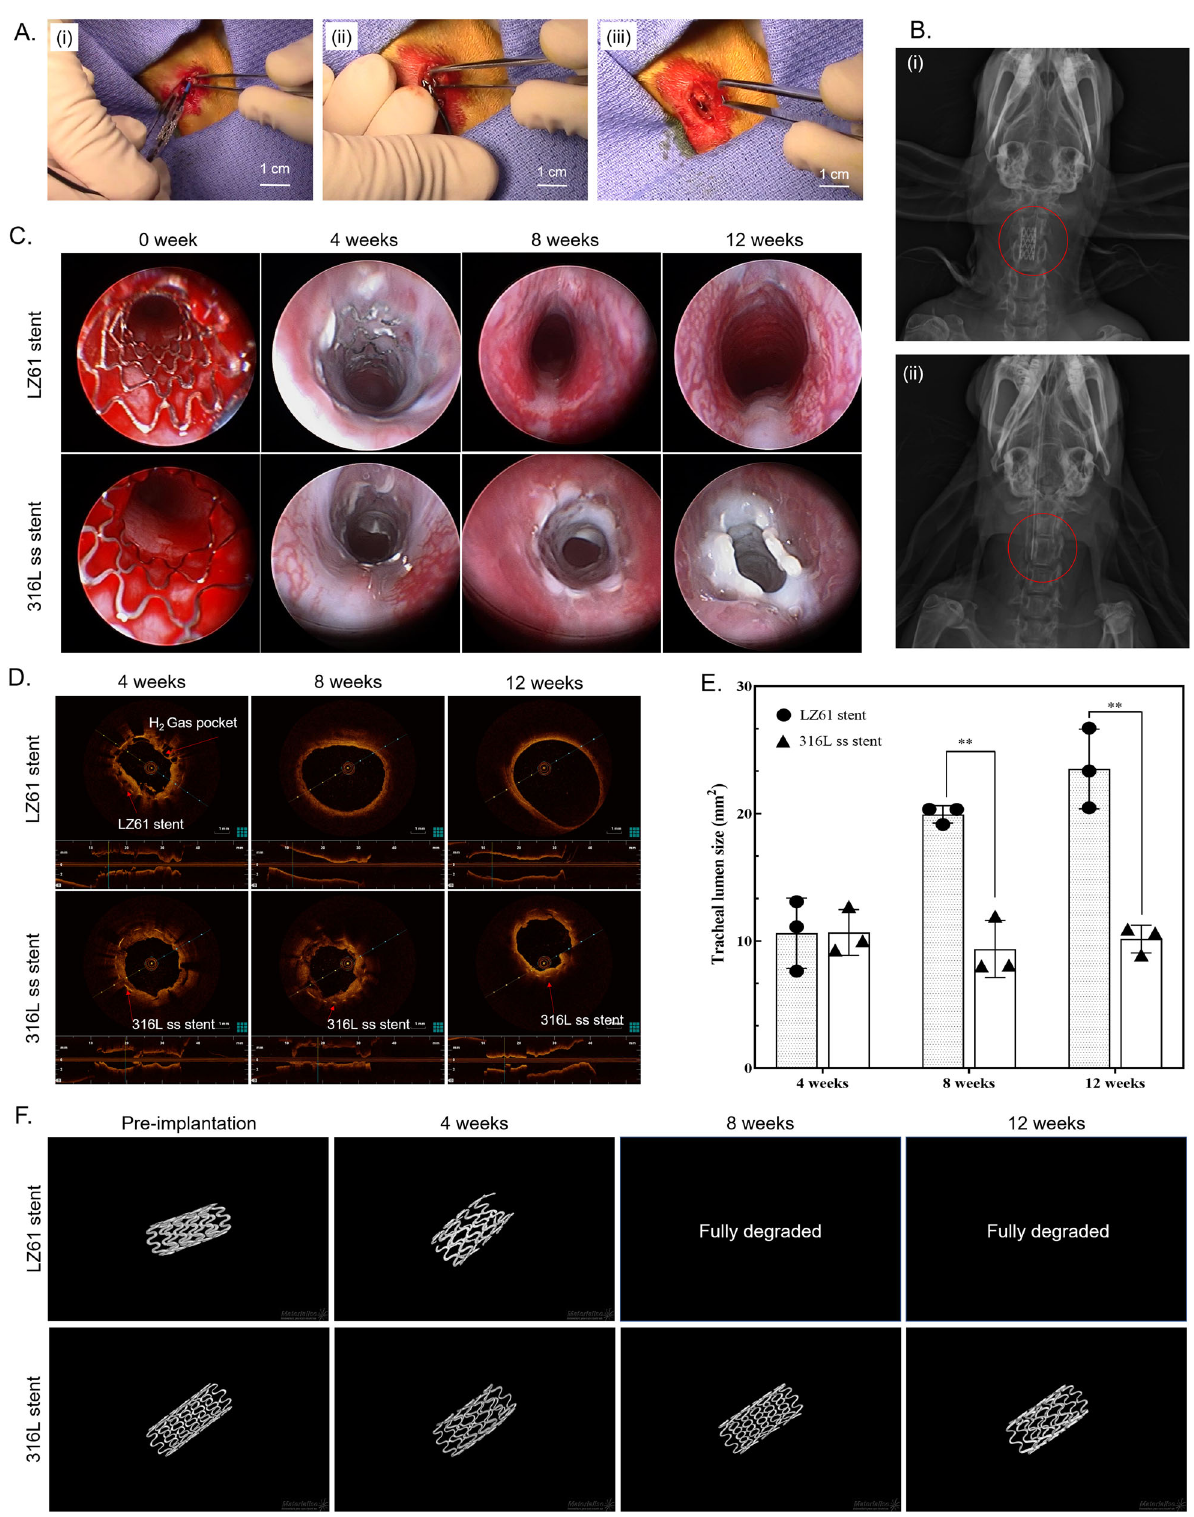
Fig. 3 In vivo implantation of LZ61-KBMS stents in a healthy rabbit tracheal model. A The surgical procedure of the stent placement. (i) Tracheal stent was mounted on the balloon. (ii) The balloon was injected with saline and expanded the tracheal stent against the tracheal wall. (iii) The balloon was de fl ated and pulled out of the trachea leaving the stent inside the tracheal lumen . B X-ray image of the implantation site of the (i) 316L SS stent and (ii) LZ61-KBMS stent after the tracheal stent implantation. The positions of the stents are circled in the images. LZ61-KBMS stent is hard to identify here under the X-ray due to the lower density. A dark shadow is only visible here. C Endoscopic images of the stented airway right after implantation, and after 4, 8, and 12 weeks of implantation. D OCT images of the cross-section of the stented airway at 4, 8, and 12 weeks after implantation. E Tracheal lumen area calculated based on the cross-section of OCT images at 4, 8, and 12 weeks. **denotes a signi fi cant difference between alloy groups ( p < 0.01, n = 3). F The 3D structure of 316L SS stents and LZ61-KBMS stents based on µ CT scan at different time point indicating the remaining stents after implantation in